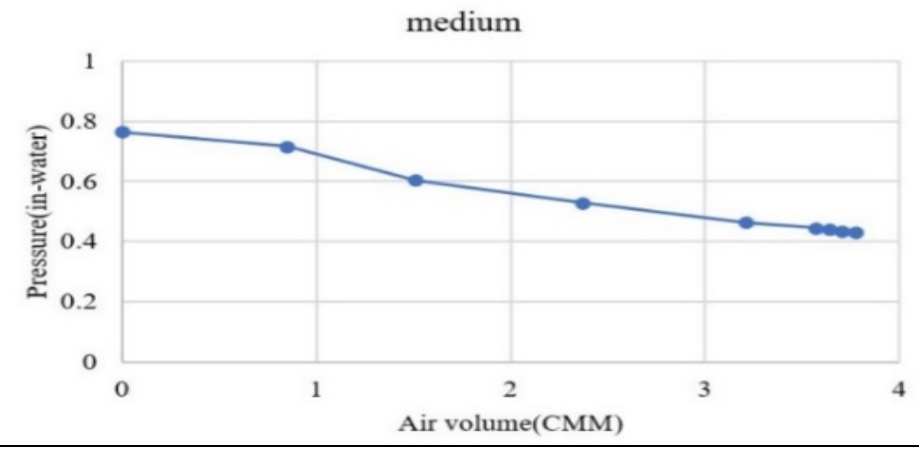
Figure 11. P-Q curve of the air purifier at a high rotation speed. 2.2. Impedance Characteristics of Filter Screens Measured with Different Materials In order to confirm the validity of the flow field simulation input parameters, an air purifier filter screen performance test was carried out using the wind tunnel experiment, as shown in Figure 12. Three different filter screen materials were installed in the equip- ment. The equipment had filter screens constructed of three layers using different materi- als, including a primary filter screen, chemical filter screen, and high-efficiency medical sterilization filter screen, as shown in Figures 13–15. The performances of the different filter screen materials were measured, as shown in Table 2. The filter screens’ velocity and pressure for all materials were obtained, while the X -axis and Y -axis were drawn as the velocity (m/s) and the P-Q curve of pressure (Pa), respectively, as shown in Figures 16–18. Other technical principles were used for the filter screens of different materials, with the descriptions shown in Table 3 [24].